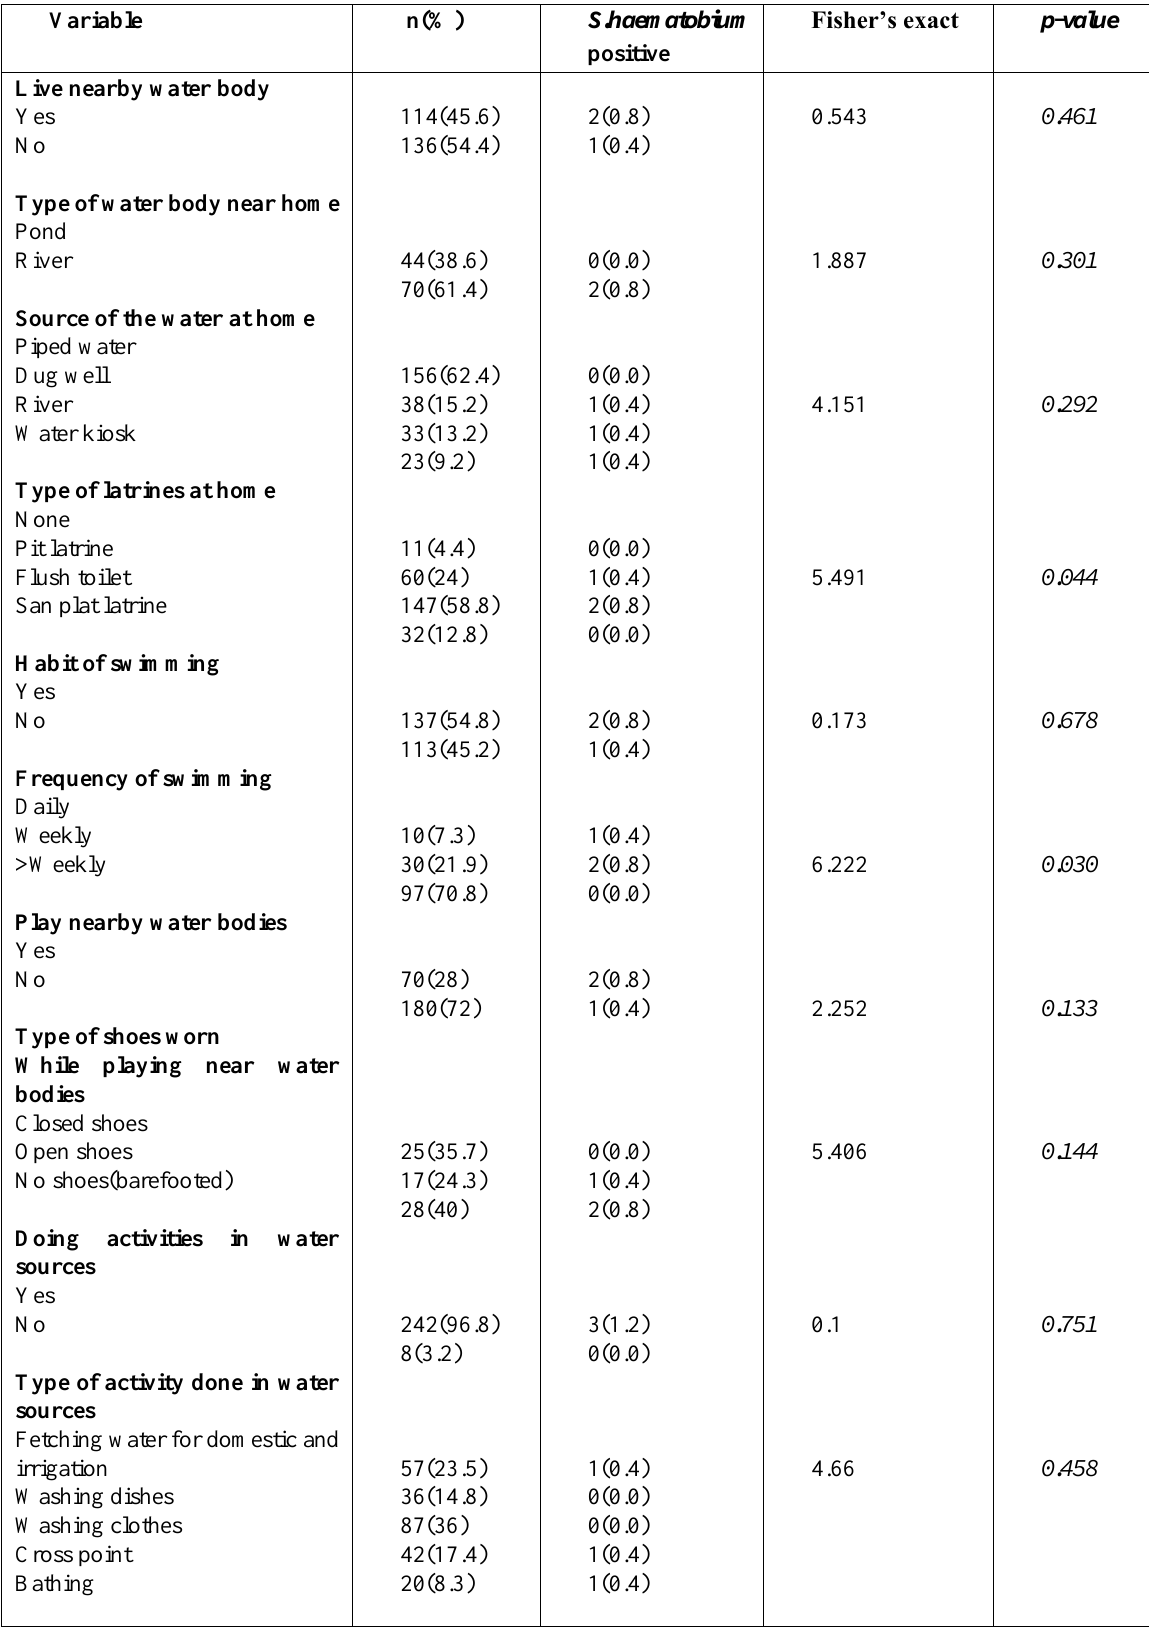
Table 4. Water, sanitation, and hygiene risk factors associated with the transmission of urogenital schistosomiasis among primary school children